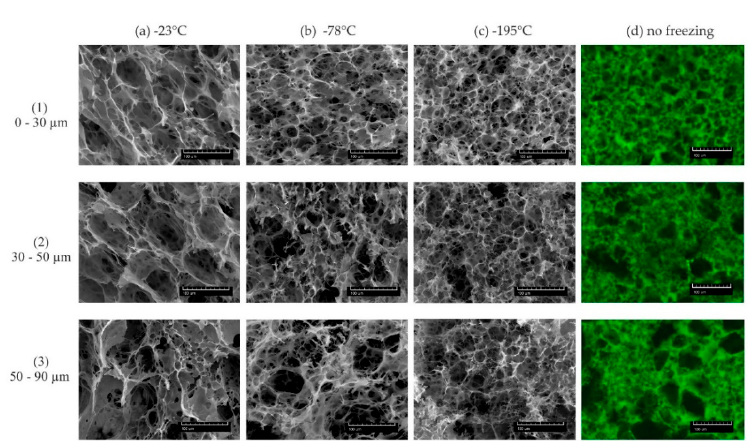
Figure 1. Comparison of the pHPMA hydrogel morphology visualized by SEM ( a – c ) and LSCM ( d